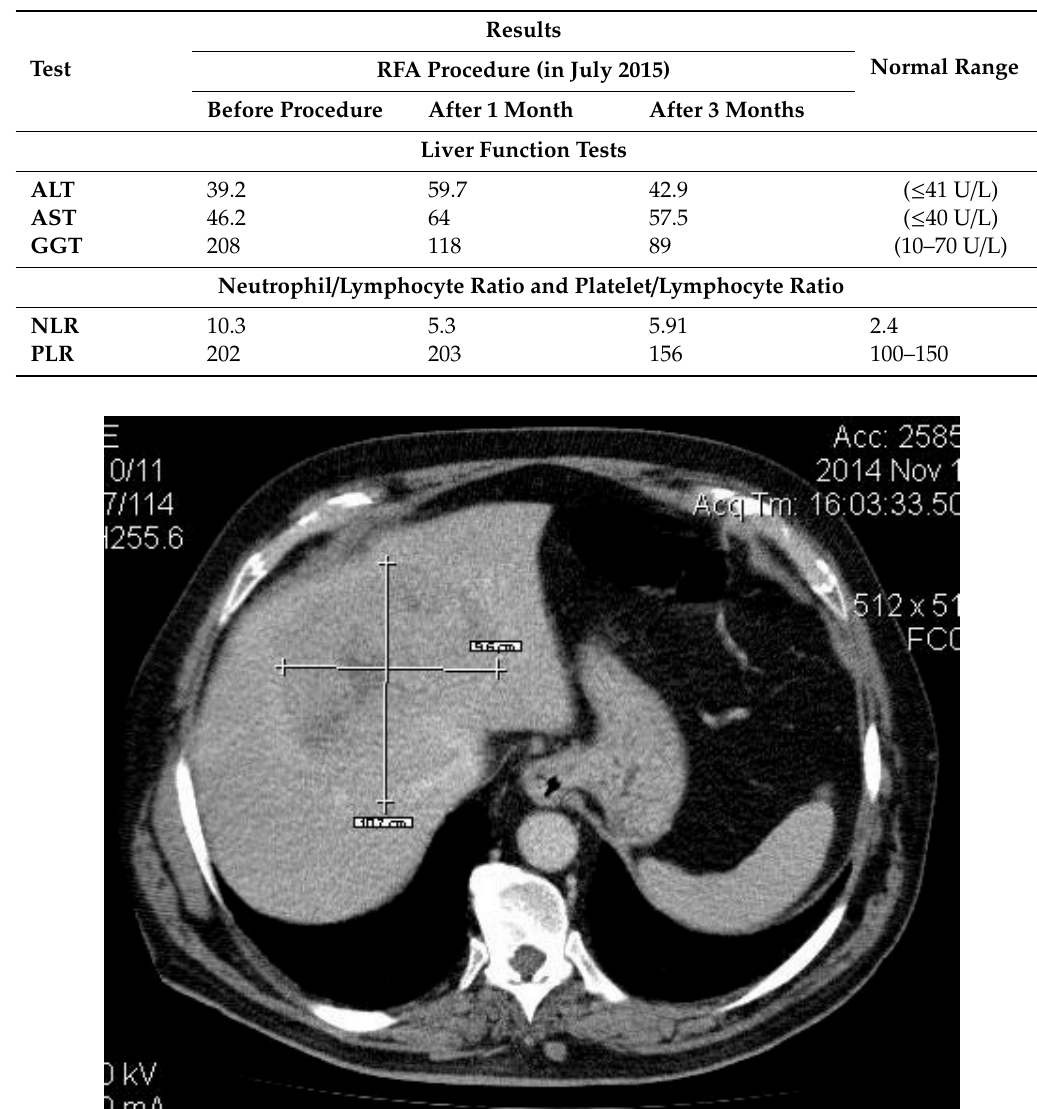
Table 1. Blood test results. Blood tests revealed moderate changes of liver enzymes. Neutrophil/lymphocyte ratio (NLR) and platelet/lymphocyte ratio (PLR) levels were decreased during the RFA treatment. RFA: radiofrequency ablation.